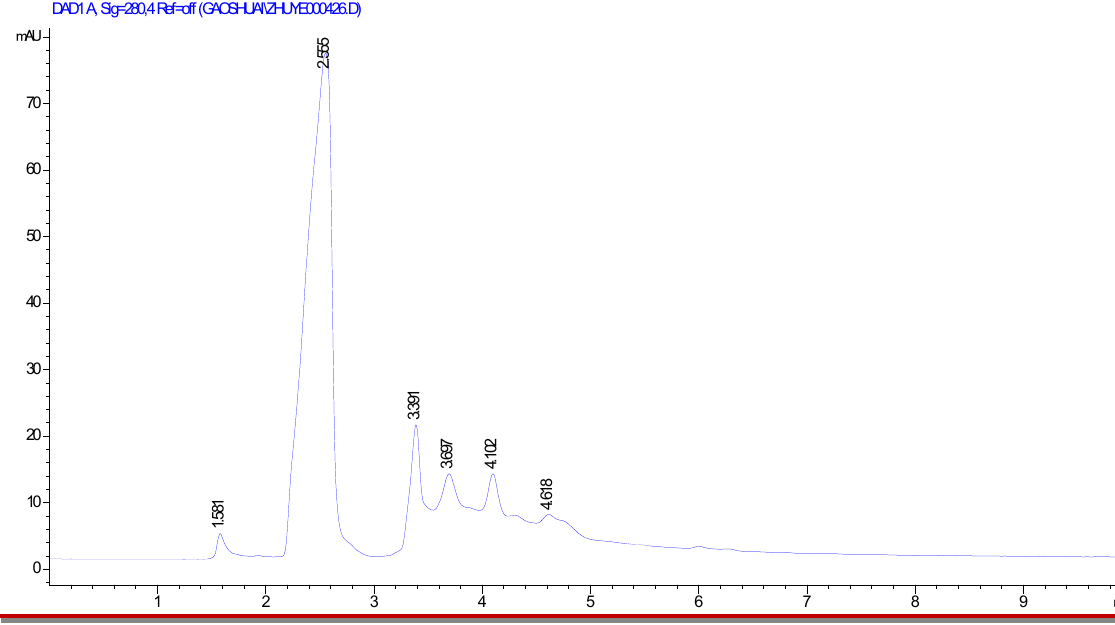
Figure 2: HPLC spectrum of PB2 purified from apple